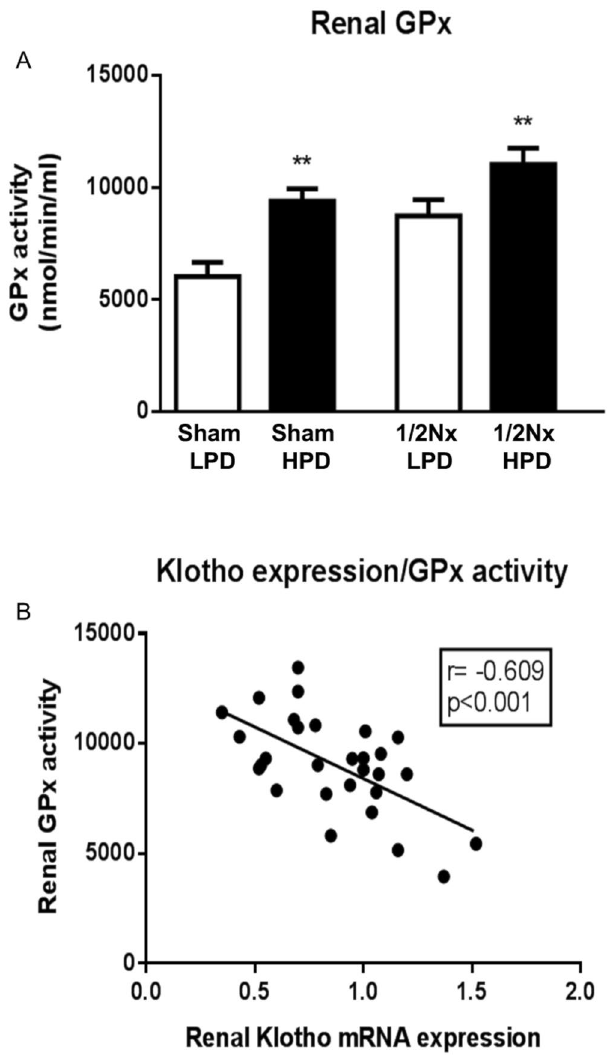
Figure 5. Elevated phosphaturia generates renal oxidative stress. Glutathione peroxidase (GPx) activity in renal tissue. ( A ) GPx activity was determined in 20 µ g of total protein extracts of kidney samples by a coupled reaction with glutathione reductase. Units are expressed as nanomoles of NADPH oxidized per minute and milliliter. White bars are LPD (0.2%P diet) groups and black bars are HPD (1.2%P diet) groups. t-test analysis * p < 0.05, ** p < 0.01. ( B ) Negative correlation between renal mRNA α -klotho expression and GPx activity.